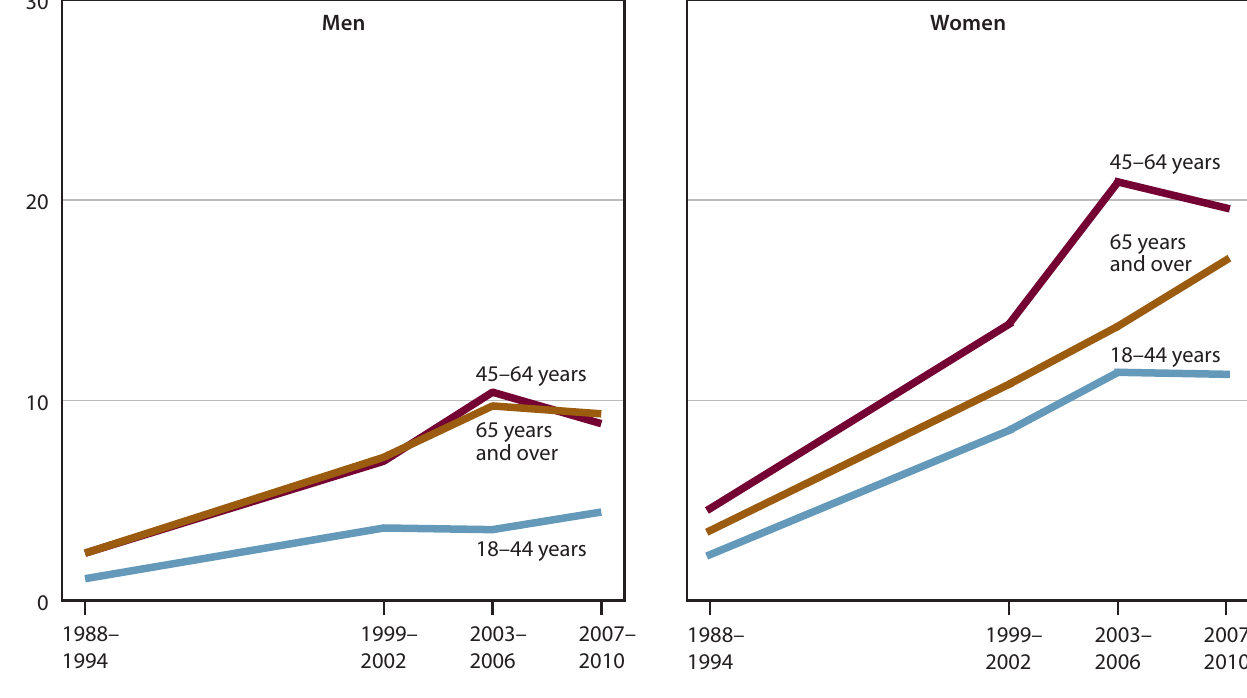
Figure 25. Use of prescription antidepressants in the past 30 days among adults aged 18 and over, by sex and